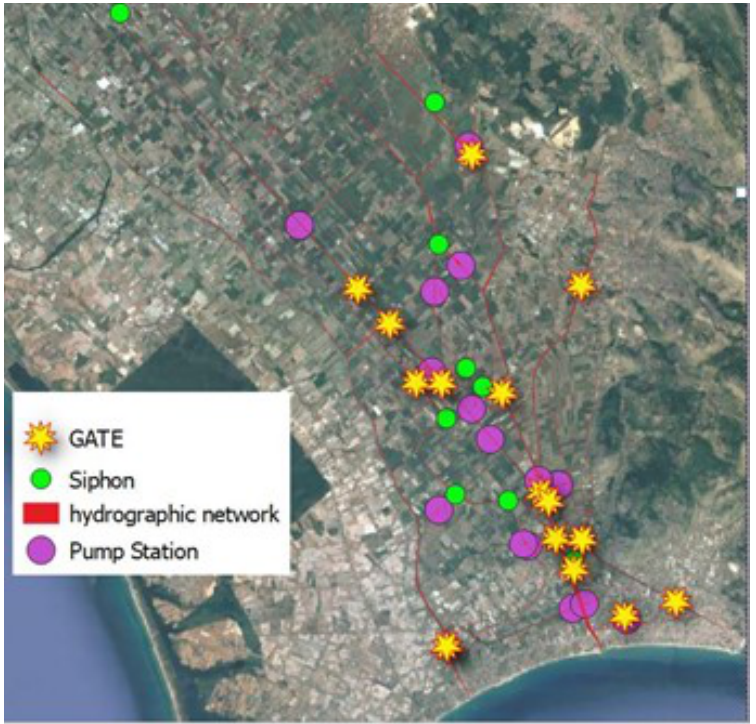
Figure 3. Hydraulic network of Pontina Plain with maneuvers, pumping stations and